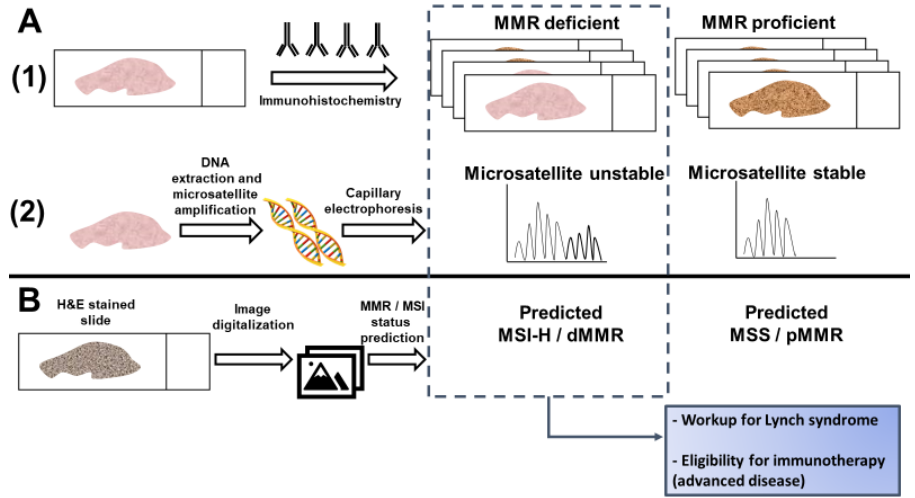
Figure 1. Detection of microsatellite instability (MSI) or mismatch repair (MMR) deficiency is performed by ( A1 ) Immunohistochemistry of the mismatch repair proteins or ( A2 ) PCR amplification of consensus microsatellite repeats that are analyzed with capillary electrophoresis. Inference of MSI/MMR status from next generation sequencing (NGS) is not presented. ( B ) MSI/MMR status can be predicted from hematoxylin and eosin (H&E) stained slides, without requiring molecular analyses (see Figure 2). Detection of MSI/dMMR has implications for Lynch Syndrome screening and deter- mining eligibility for immune checkpoint blockade in advanced disease. MSS: microsatellite stable. MSI-H: high mi- crosatellite instability. pMMR: proficient mismatch repair. dMMR: deficient mismatch repair. 2. Histological and Clinical Predictors of Microsatellite Instability With the significant cost and non-universal availability of the molecular testing re- quired to determine MMR/MSI status, studies have sought to predict MSI based on rou- tinely available data, such as clinical information and histopathology [26]. CRC tumors with MSI are associated with certain histological features, detectable via standard H&E staining, and clinical data, such as patient age and tumor location [26–28]. Similar obser- vations have been made in other tumors enriched for MSI, such as endometrial cancer [29]. These associations may present a means of identifying the tumors most likely to have the dMMR phenotype, and therefore the patients most likely to benefit from addi- tional testing. They may also help to identify those at low risk who would be less likely to benefit. The targeted deployment of MMR/MSI testing could reduce costs and save re- sources [26]. Inferring MSI status may be considered in settings where MSI testing is not performed but is unlikely to be adopted in resource-rich settings unless the prediction accuracy is near-perfect. Several clinicopathologic predictors of MSI have been discovered and several groups have proposed models for MSI prediction (Table 1). Histological features such as signet ring cells, mucinous or medullary morphology, and poor differentiation are sig- nificantly associated with MSI status, but show poor sensitivity for MSI prediction on their own [27,30]. Correlations between MSI and immunological features of tumor pa- thology, such as measurements of tumor infiltrating lymphocytes (TILs) [11,26,28,31] and specific histological structures such as the Crohn’s-like lymphoid reaction (CLR), are well established in the literature [18,26,28]. CLR represents CRC-specific tertiary lym- phoid aggregates [18]. The host response to MSI tumors is attributed to the high tumor mutational burden (TMB) and the abundance of immunogenic mutations, including in- sertion-deletion mutations, but other factors may contribute [32–34]. The Revised Be-